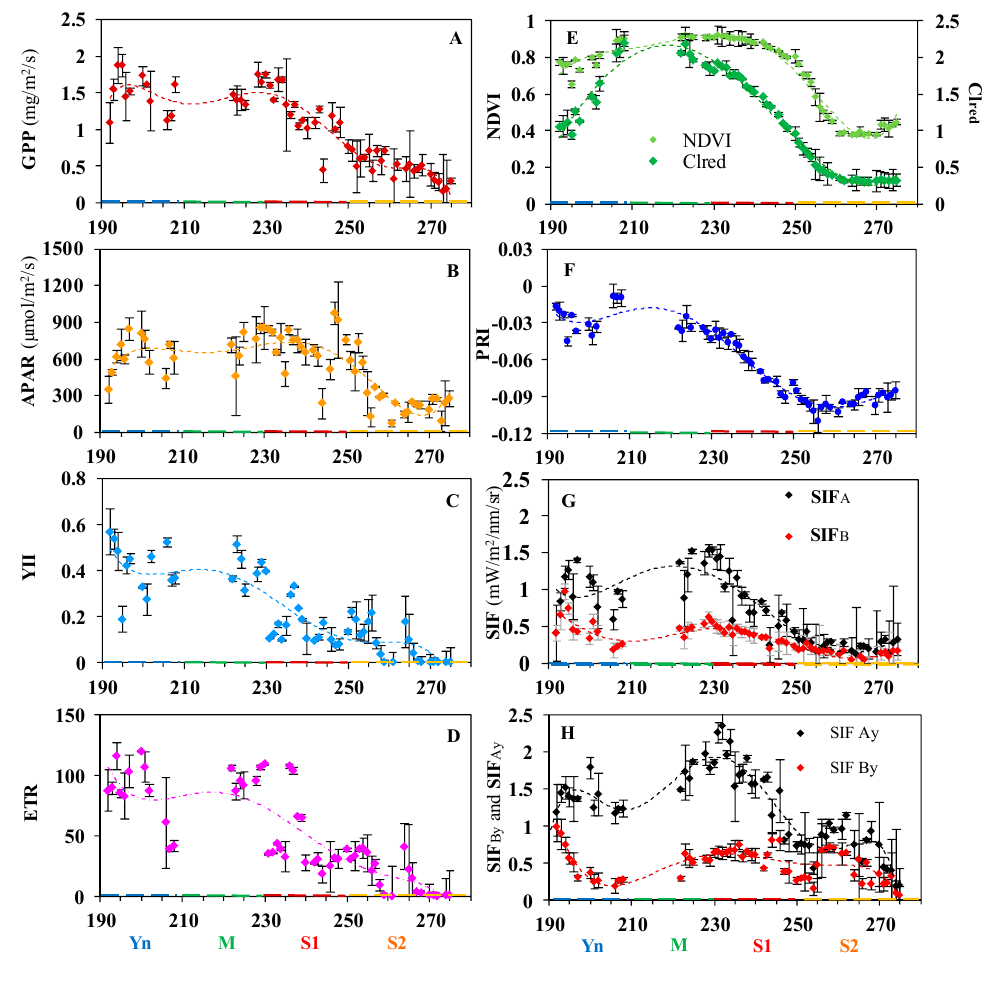
Figure 3. Seasonal variation in midday canopy gross primary production (GPP, A), absorbed photosynthetically active radiation (APAR, B), leaf photochemical efficiency of photosystem two (YII, C) and electron transport rate (ETR, D), vegetation indices (NDVI, Cl red and PRI, E–F), solar induced fluorescence (SIF, G), and SIF yield metrics (SIFy, H). Each value represents an ANOVA GLM mean of four midday observations (e.g., 11:45–13:15 EDT, 30 min. interval). Error bars denote ±SD of the mean. The corn growth stages are depicted with colored lines (blue—young/Yn, green—mature/M, red—early senescence/S1, yellow—late senescence/S2). Refer to Table 1 for measurement units.